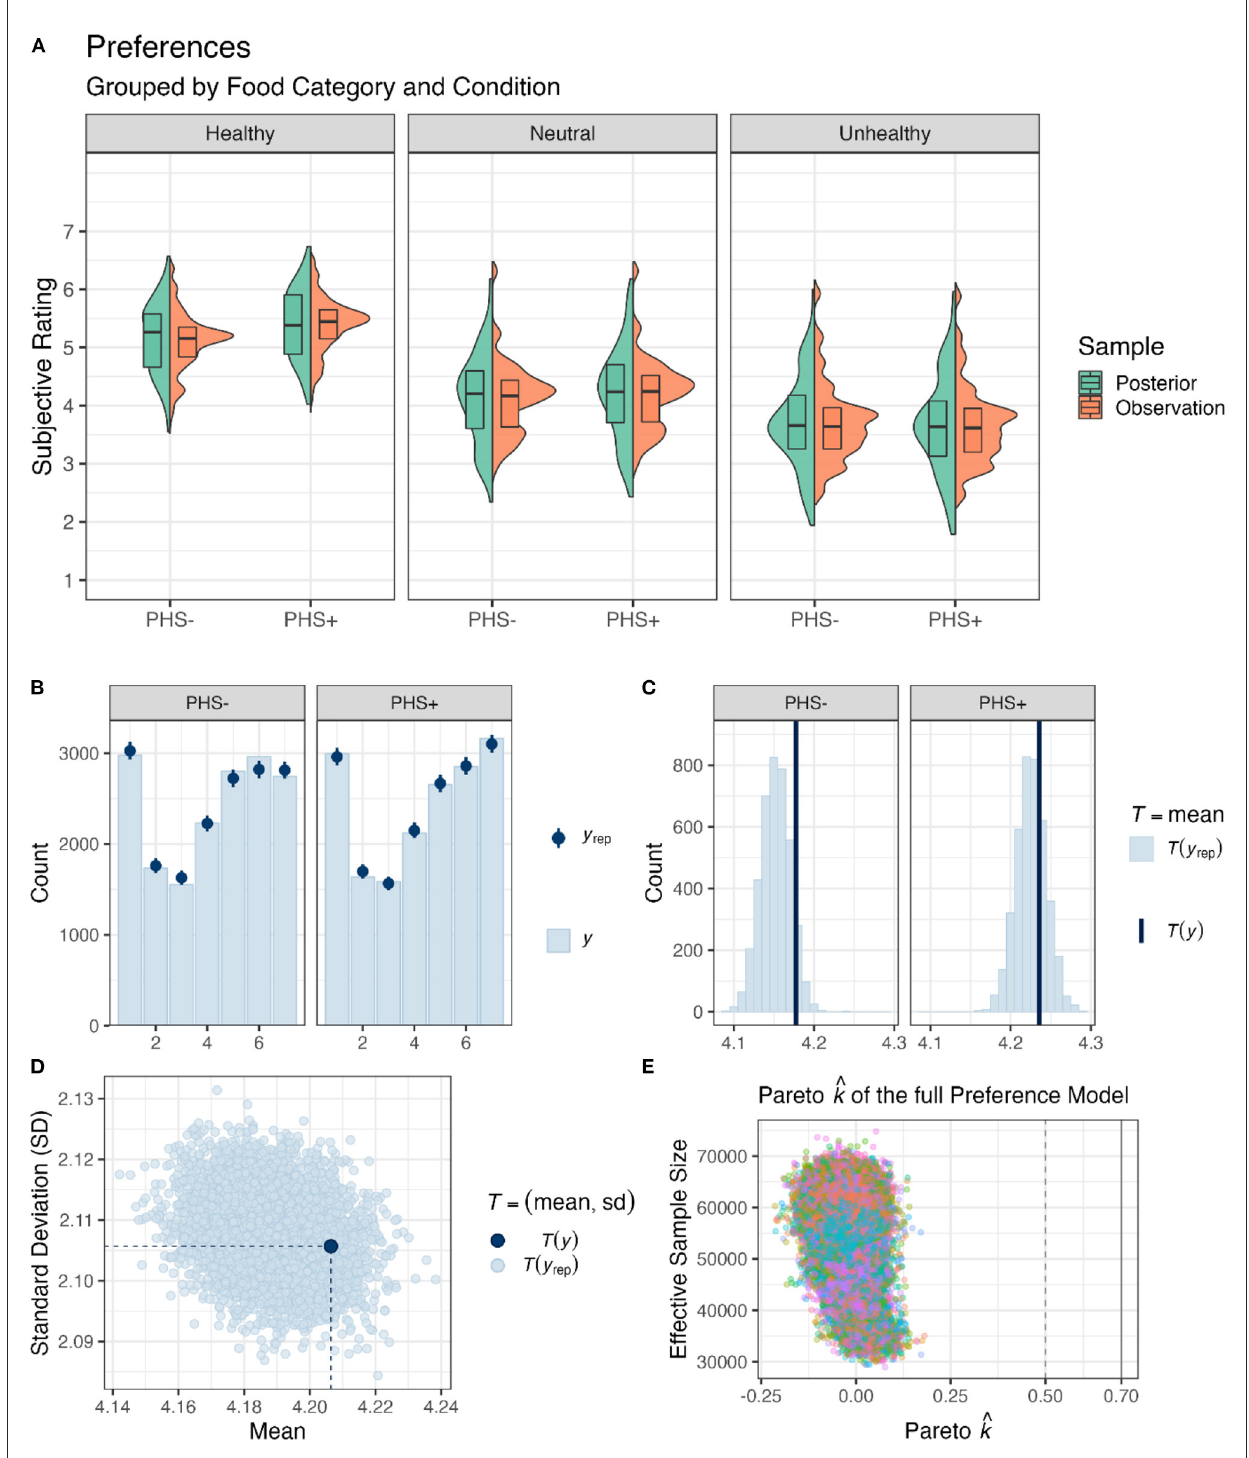
FIGURE2 Food preferences. (A) Box and violin plots of the average preferences per participant for different food categories and PHS conditions pooled over Session. Green shapes depict observed data, and orange ones are from posterior distribution derived from the full Preference Model. (B) Means and standard error estimations, obtained from posterior distributions of preference ratings ( y rep ) per level of the scale in both PHS conditions, are depicted by dark blue points and lines; light blue bars depict means of observed data ( y ). (C) Frequency density bar plots showing the estimated ( y rep ) and observed mean preferences ( y ) in both PHS conditions. (D) A scatter plot showing the diffusion of subjective ratings. Light blue dots ( y rep ) are estimated based on posterior distributions, and the dark blue dot ( y ) is the observed value. (E) Pareto ˆ k values for the full Prefences Model are depicted against the effective sample sizes for importance